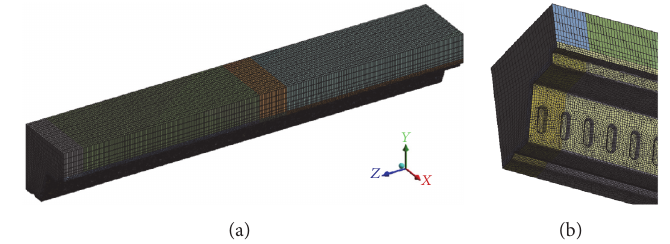
Figure 5: Composite slab model for m - k test. Mesh detail.